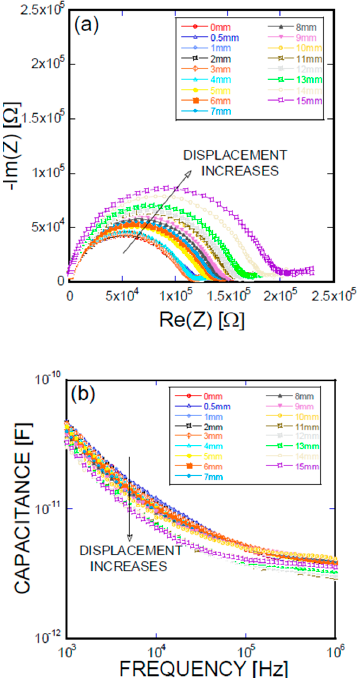
Figure 5. ( a ) Impedance spectra and capacitance Bode plots as a function of displacement obtained for an S-type Ni/Ti SMA fiber pullout; ( b ) mechanical load and electrical resistance extracted as a function of wire displacement obtained for an S-type Ni/Ti SMA fiber pullout.